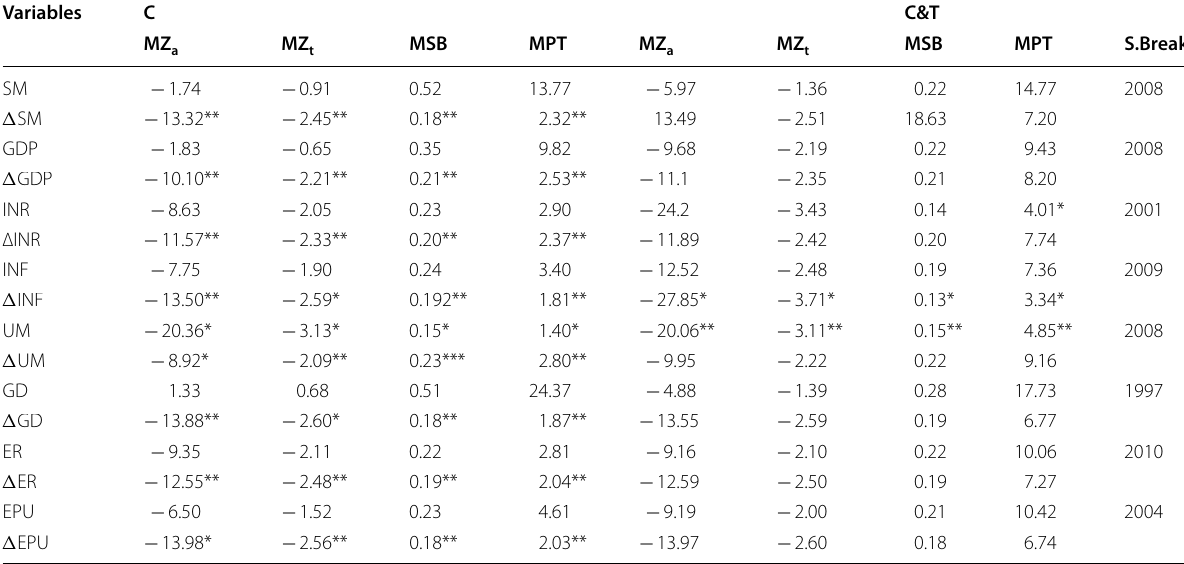
Table 3 Ng-Perron unit root